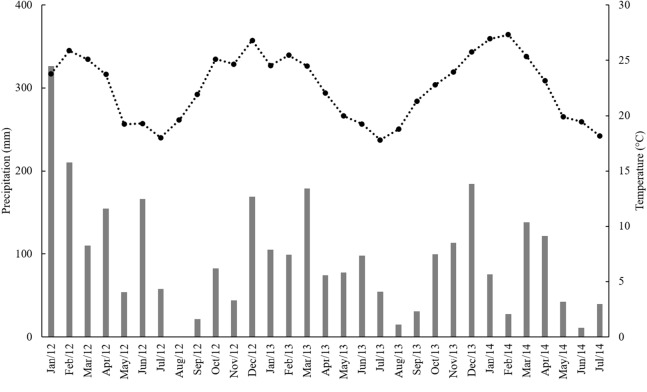
Monthly precipitation (mm) (gray bars) and mean temperature (°C) (black squares) from January 2012 to July 2014.